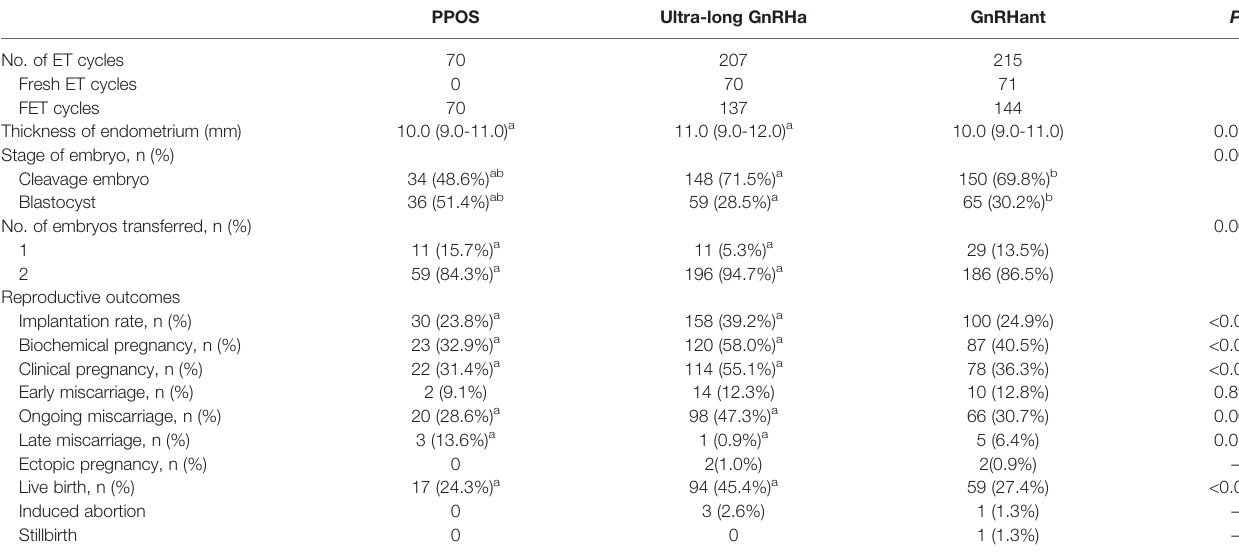
TABLE 3 | Pregnancy outcomes of patients ’ fi rst embryo transfer cycles originating from the three COS